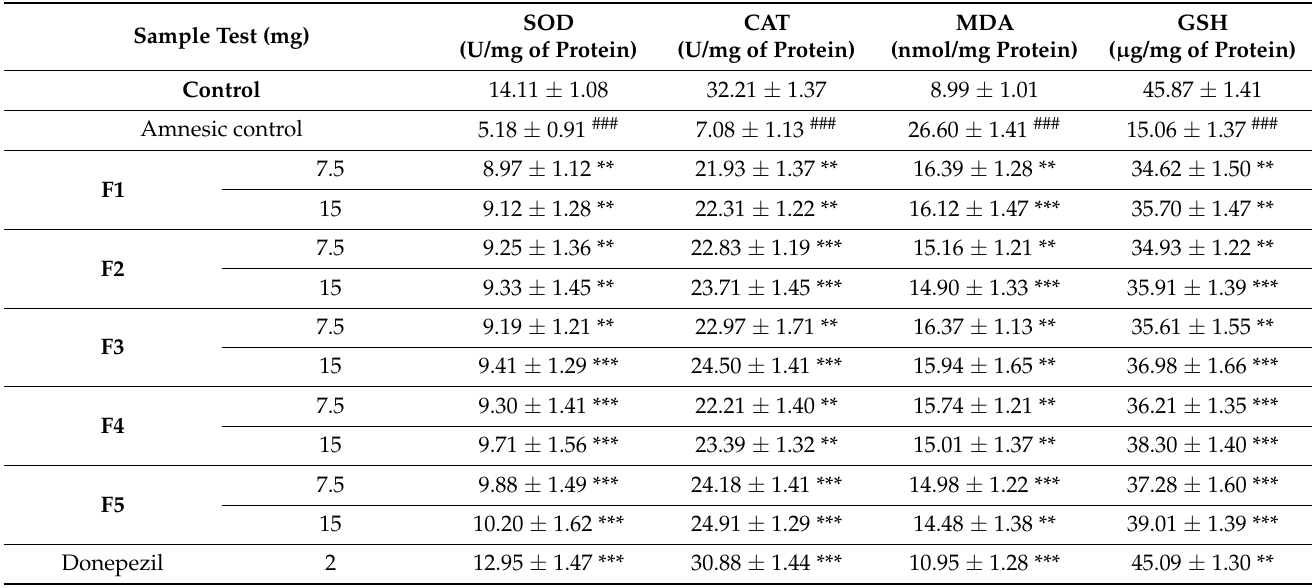
Table 6. Effects on biomarker levels in the